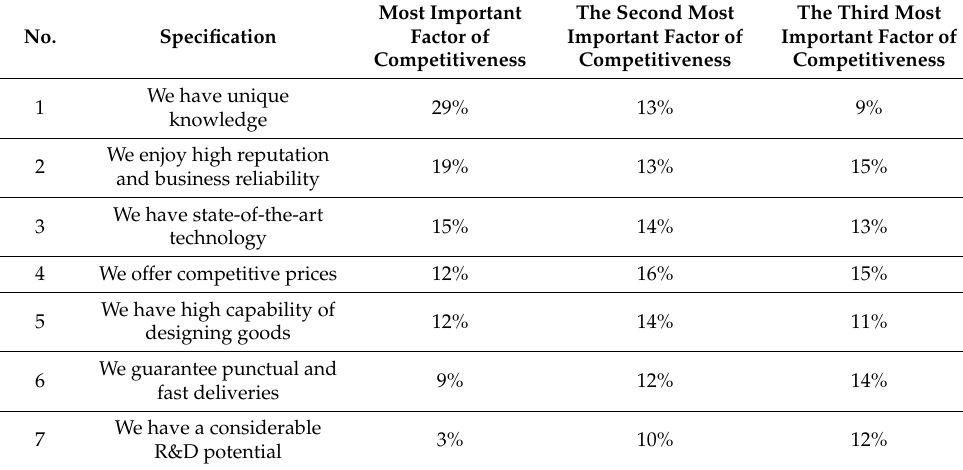
Table 4. The sources of competitiveness of the